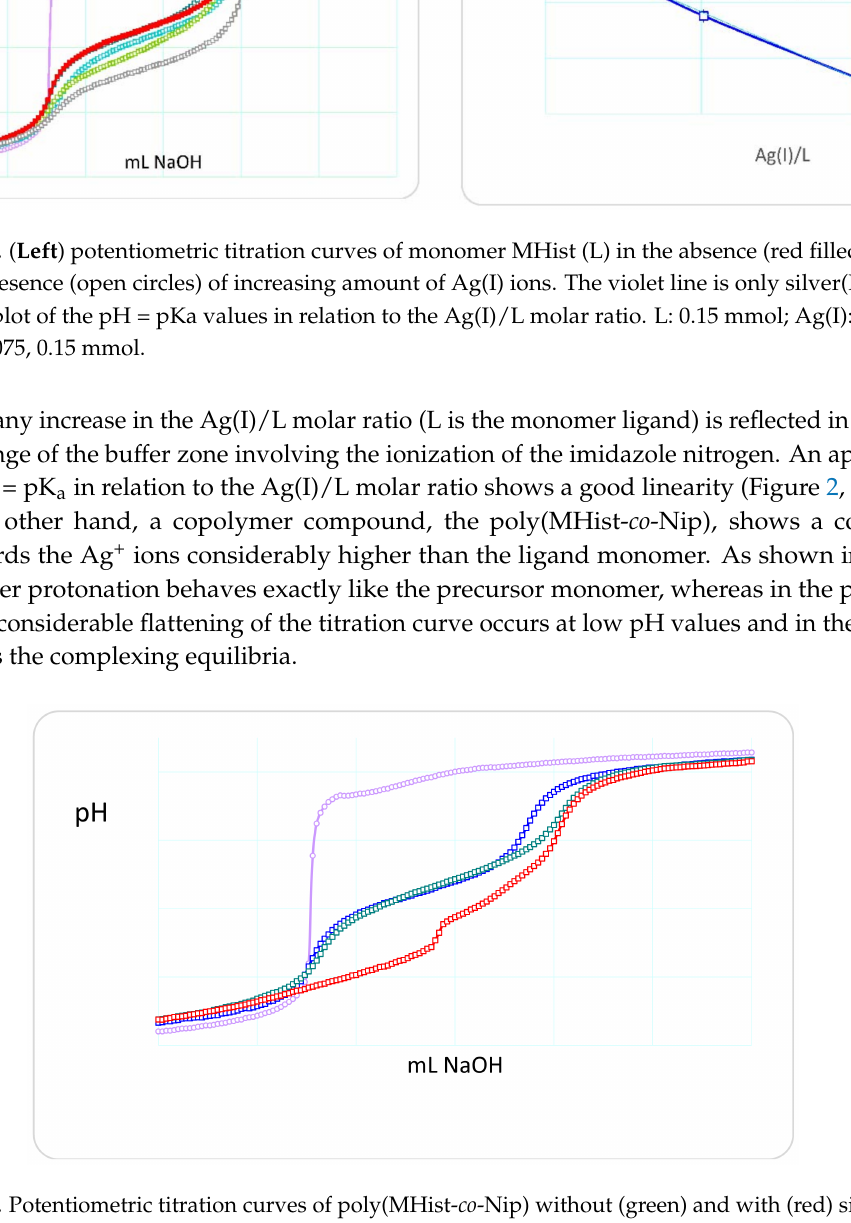
Figure 3. Potentiometric titration curves of poly(MHist- co -Nip) without (green) and with (red) silver(I) ions in the Ag(I)/L = 0.5 molar ratio. The titration curve of monomer MHist (blue) and silver(I) (violet) is also reported for